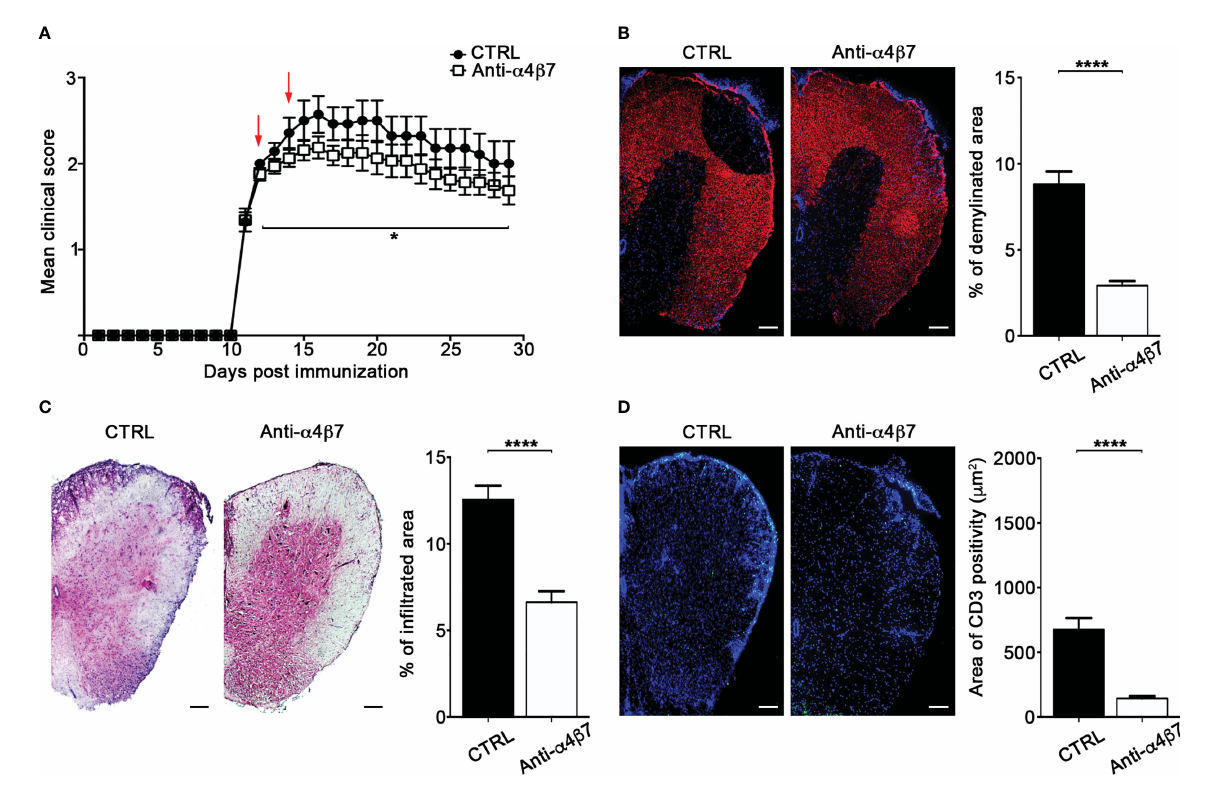
FIGURE 8 Intrathecal treatment with an anti- a 4 b 7 blocking antibody ameliorates EAE. EAE mice were intrathecally injected with 10 m l PBS containing 50 m g of isotype control antibody (CTRL) or anti- a 4 b 7 blocking antibody the day after disease onset and 2 days later. Some mice were euthanized 3 days after the fi rst antibody injection for spinal cords neuropathology assessment. (A) EAE progression was measured by daily scores for the severity of clinical disease symptoms. Red arrows indicate intrathecal antibody administration. Data represent the mean ± SEM of 29 mice per condition from three independent experiments (* P < 0.05). Representative spinal cord sections and relative quantitative analysis of (B) demyelination, (C) in fl ammatory in fi ltrates and (D) CD3+ T cells, from mice treated with control (CTRL) or anti- a 4 b 7 antibodies. 4 – 6 cross sections of spinal cord of 3 mice were analyzed. Error bars indicate SEM (**** P < 0.0001). Scale bar = 100 m